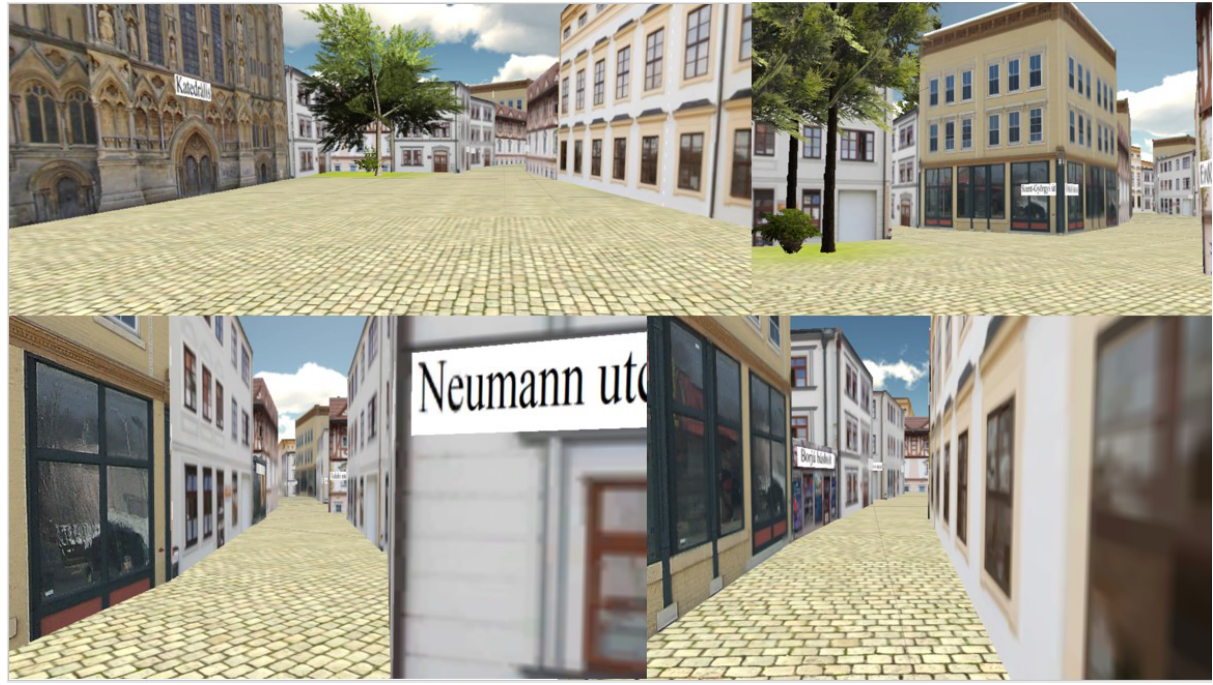
Figure 1. Street views of the imaginary town ‘Szegvár’: the navigational environment constructed for the virtual